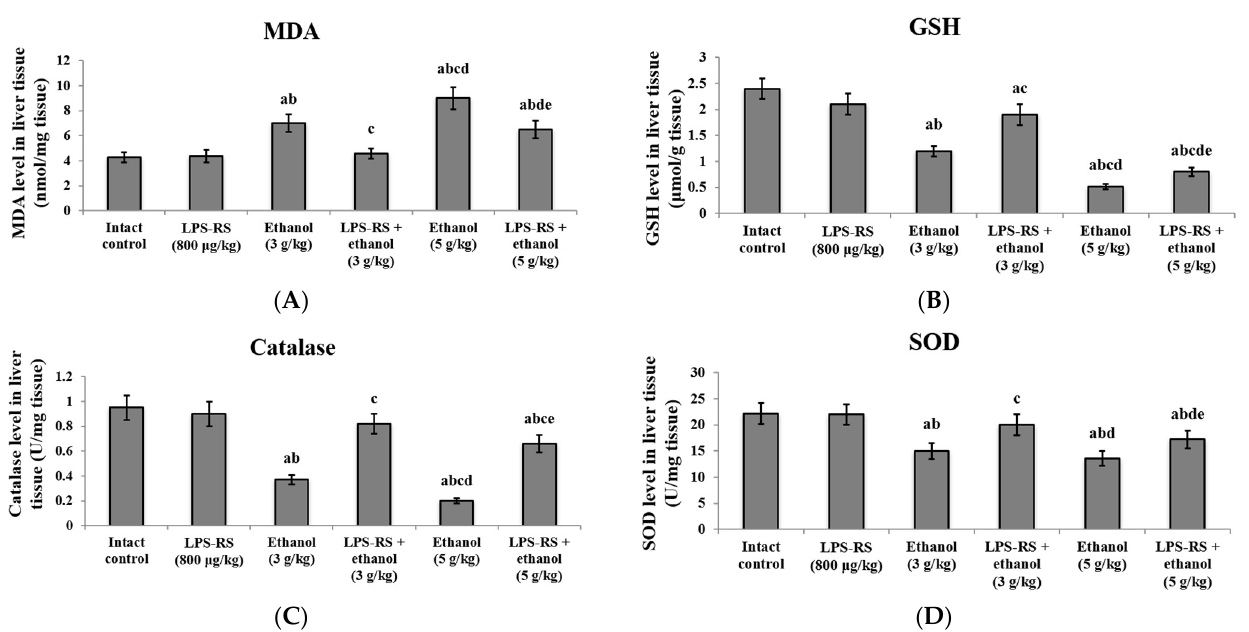
Figure 1. The anti-oxidant effects of LPS-RS (800 μg/kg) in the liver tissue of the experimental rats. Levels of ( A ) MDA, ( B ) GSH, ( C ) catalase, and ( D ) SOD. MDA, malondialdehyde; GSH, reduced glutathione; SOD, superoxide dismutase. Data are expressed as mean ± SD and analyzed using one-way ANOVA followed by Bonferroni’s post-hoc test ( n = 8–10). Differences were considered significantly different at p < 0.05. a vs. intact control; b vs. LPS-RS; c vs. ethanol (3 g/kg); d vs. LPS-RS + ethanol (3 g/kg); e vs. ethanol (5